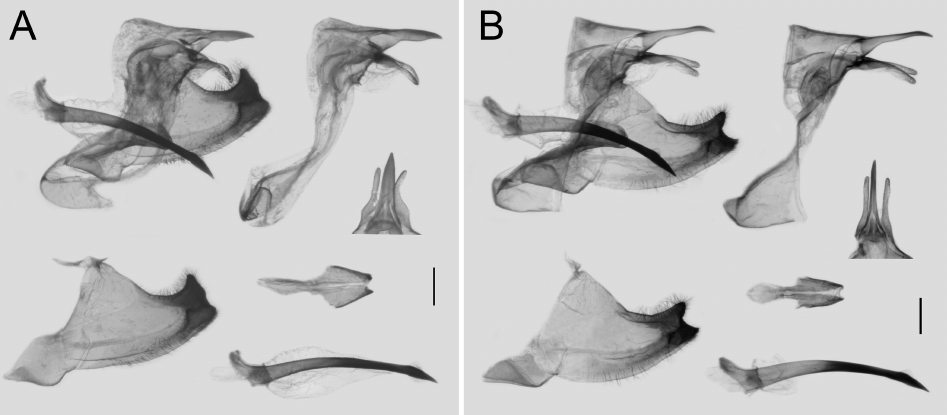
Figure 5. Comparison of male genitalia of Losaria coon ( A ) and L. doubledayi ( B ); scale bars = 1.0 mm. Female genitalia of available subspecies were dissected, constant di ff erences were found between L. coon and L. doubledayi , while the characters remain consistent within each group, as shown in Figure 6. The main di ff erences in female genitalia are: (1) the ostium is smaller in L. coon but broader in L. doubledayi ; (2) the lamella antevaginalis sunk inwardly, forming a crescent edge, in L. coon, while forming an even edge in L. doubledayi ; (3) the lamella postvaginalis is 0.5 to 0.7 times shorter and 1.8 to 2.0 times broader in L. coon than that in L. doubledayi ; (4) the lateral area surrounding the ostium is